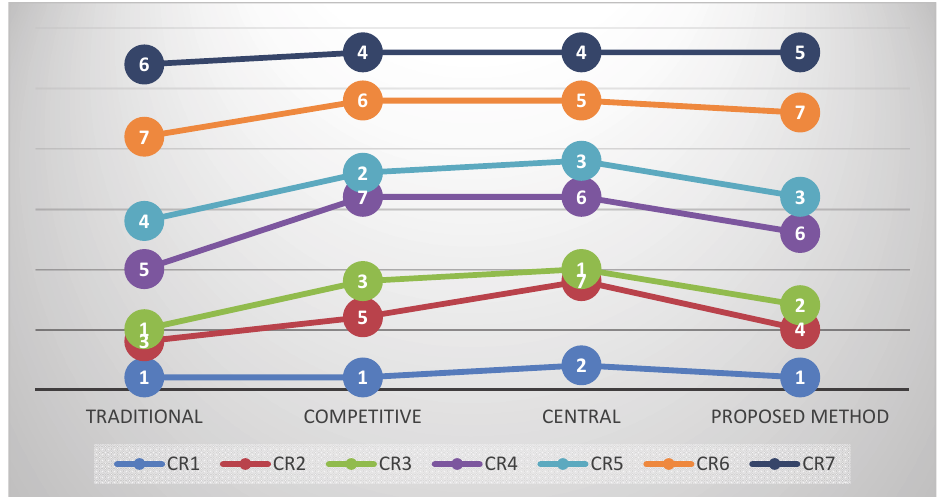
Fig. 4. Ranking the relative weight of demands using the different